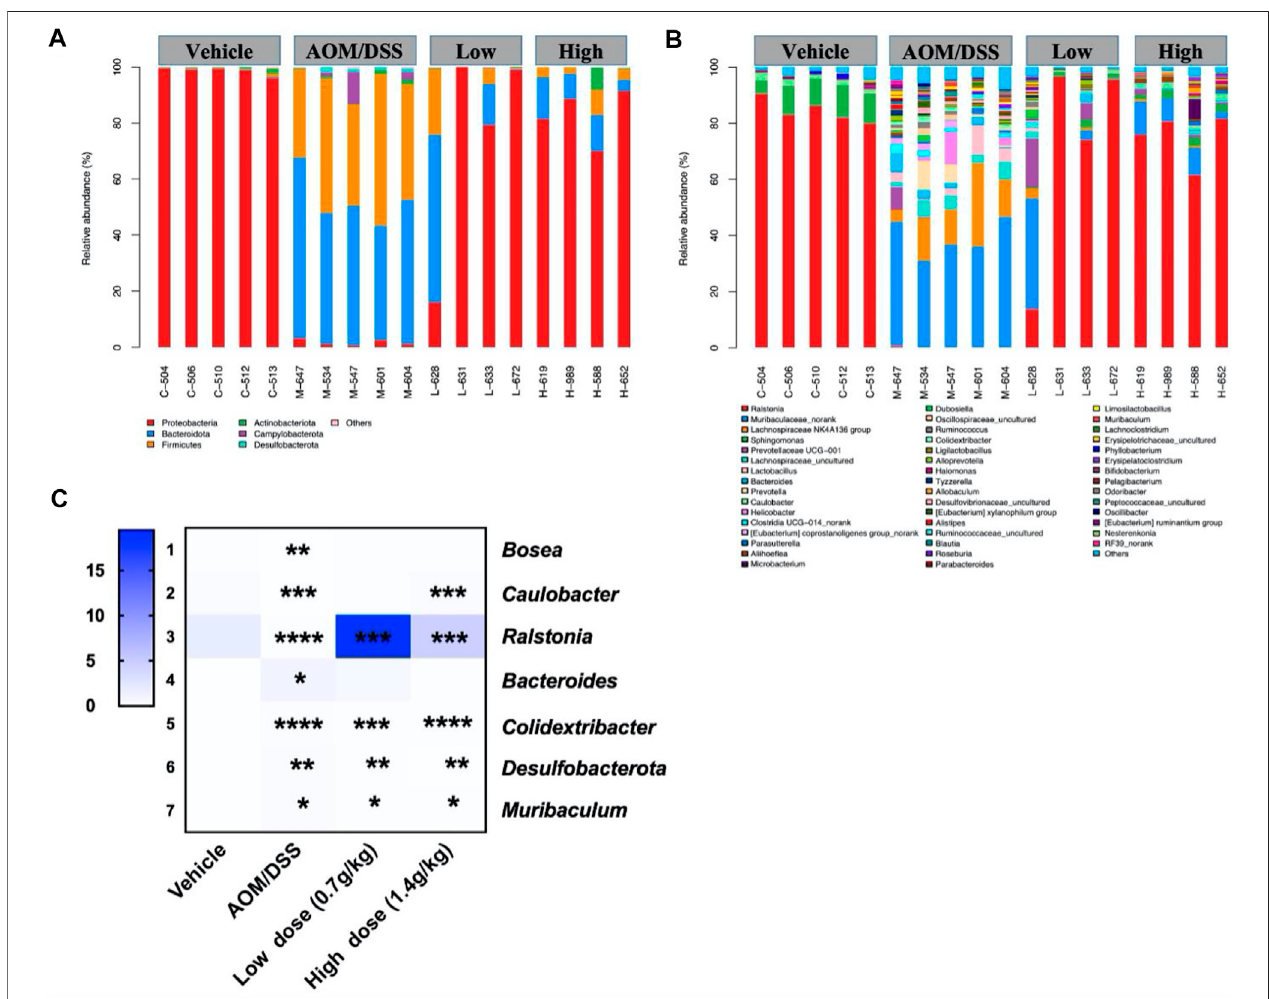
FIGURE 3 | Gut microbial community structure in AOM/DSS mice after QCWZD treatment. (A) Microbial community bar plot according to phylum. (B) Microbial community bar plot according to genus. (C) Heatmap ofgut microbiota abundance at the phylum and genus levels. Low dose: 0.7 g/kg, High dose: 1.4 g/kg * p < 0.05, ** p < 0.01, *** p < 0.001, **** p < 0.0001.